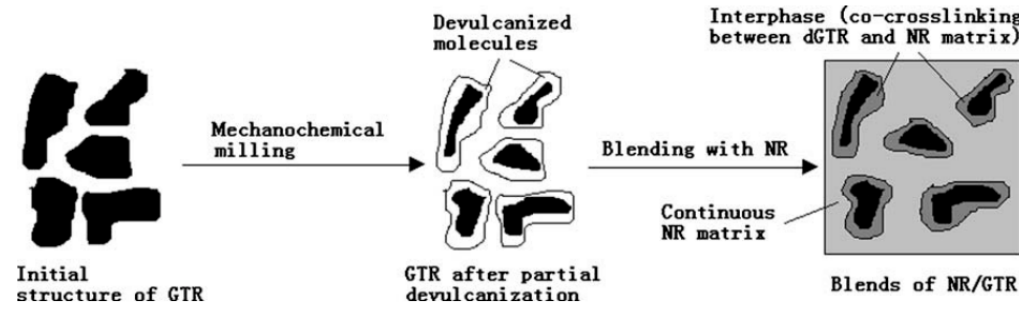
Figure 29. Schematic representation of the partial regeneration process and its effect on the morphology of rubber blends (reproduced with permission from [124]).